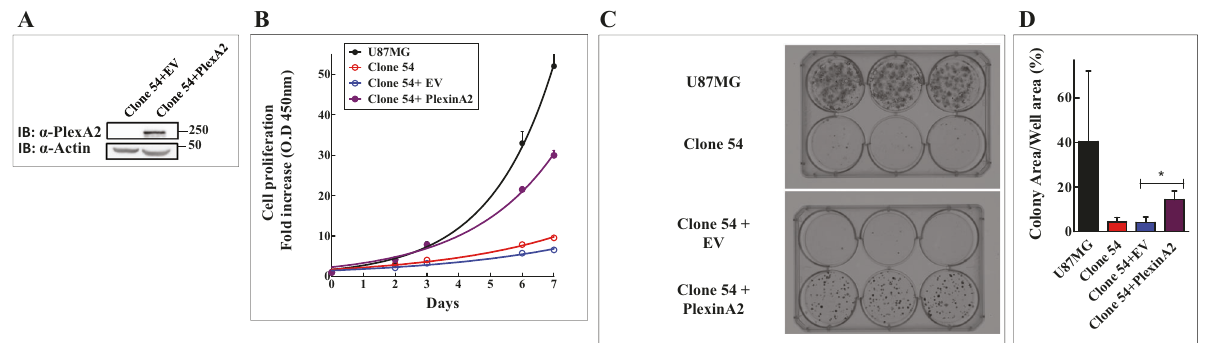
Fig. 3 Re-expression of plexin-A2 cDNA in plexin-A2 knock-out cells, restores their proliferation and colony forming ability. A U87MG KO clone 54 cells were infected with an empty lentiviral expression vector (EV) or with a lentiviral vector directing expression of plexin-A2 (PlexA2). Western blots prepared from cell lysates were probed with antibodies directed against plexin-A2 and actin. B U87MG cells, U87MG clone 54 cell and clone 54 cells infected with empty lentiviruses (EV) or lentiviruses directing expression of plexin-A2 (PlexinA2) were seeded in quadruplicate in 96 well dishes. Cell proliferation was determined using the WST-1 assay as described. Shown is a representative experiment out of N = 4 independent experiments. Data are represented as mean ± SD. C U87MG cells, U87MG clone 54 cells and U87MG KO clone 54 cells infected with an empty lentiviral expression vector (EV) or with a lentiviral vector directing expression of plexin-A2 (PlexinA2). Cells were seeded in 6 well plates (300 cells/well). After 16 days colonies were fi xed in 4% para-formaldehyde and stained with crystal violet. The experiment was repeated three times with similar results. D The areas of the colonies formed by the indicated cell types out of the entire well area was determined and is represented as a percentage of the total area. Data are represented as mean ± SD. Statistical analysis was done using the one tailed Mann-Whitney test. * P < 0.05, N =